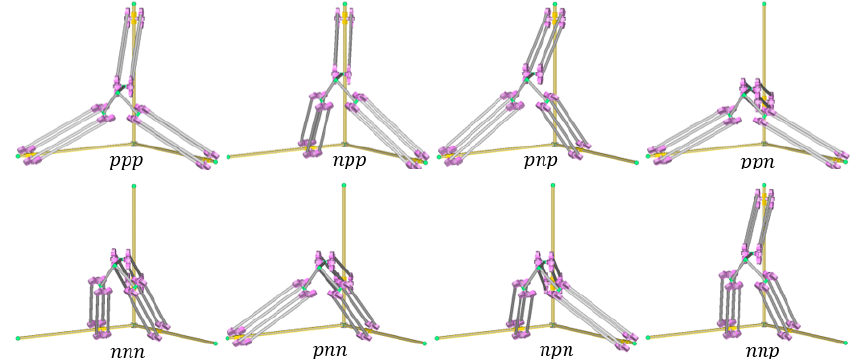
Figure 6. The eight existing working